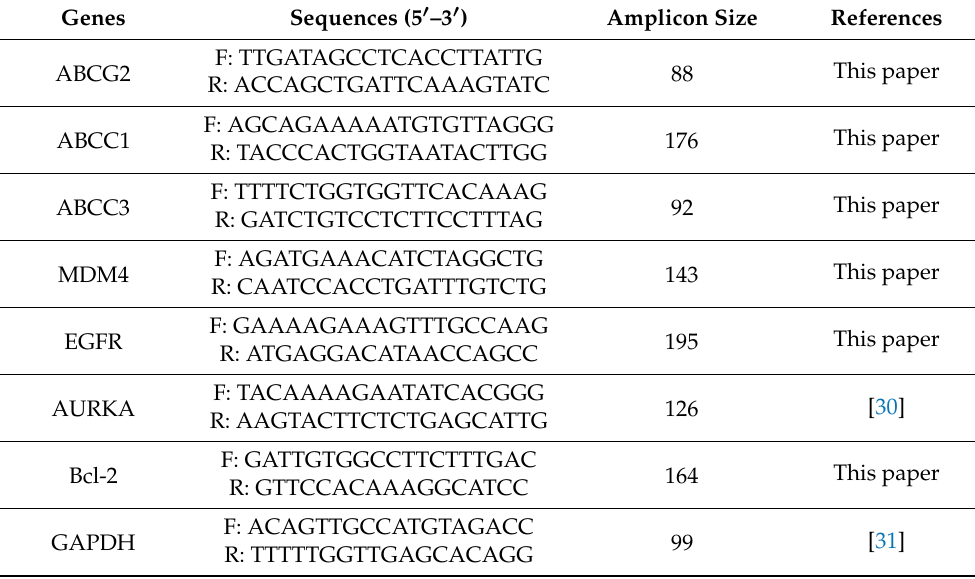
Table 2. Primers used in